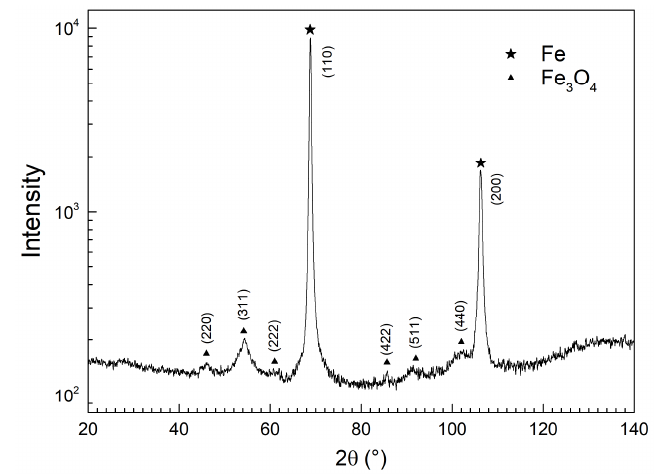
Figure 1. X-ray diffraction of the synthesized “Fe” powder. Intensity is given in logarithmic scale.